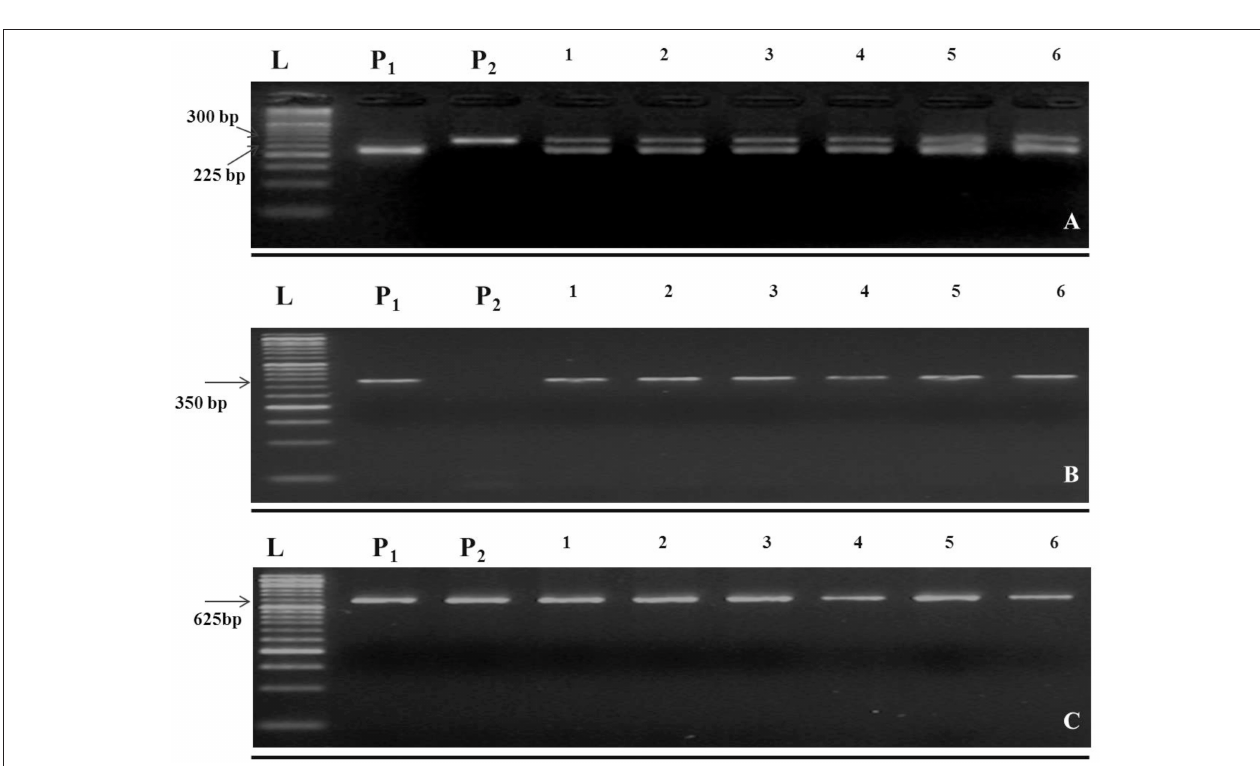
FIGURE 3 | Molecular markers used in inter-specific hybridity testing of B. oleracea botrytis group “Pusa Sharad” (C genome) and B. carinata “NPC-9” (BC genome). (A) Codominant SSR NI2-C01. (B) B genome specific primer (DB) amplified 350 bp size. (C) C genome specific primer (DC) amplified 625 bp. P 1 ; NPC-9 and P 2 ; Pusa Sharad, 1-6; F 1 individuals, M = 50 bp DNA ladder. ( A–C were grouped together and separated using black horizontal line).